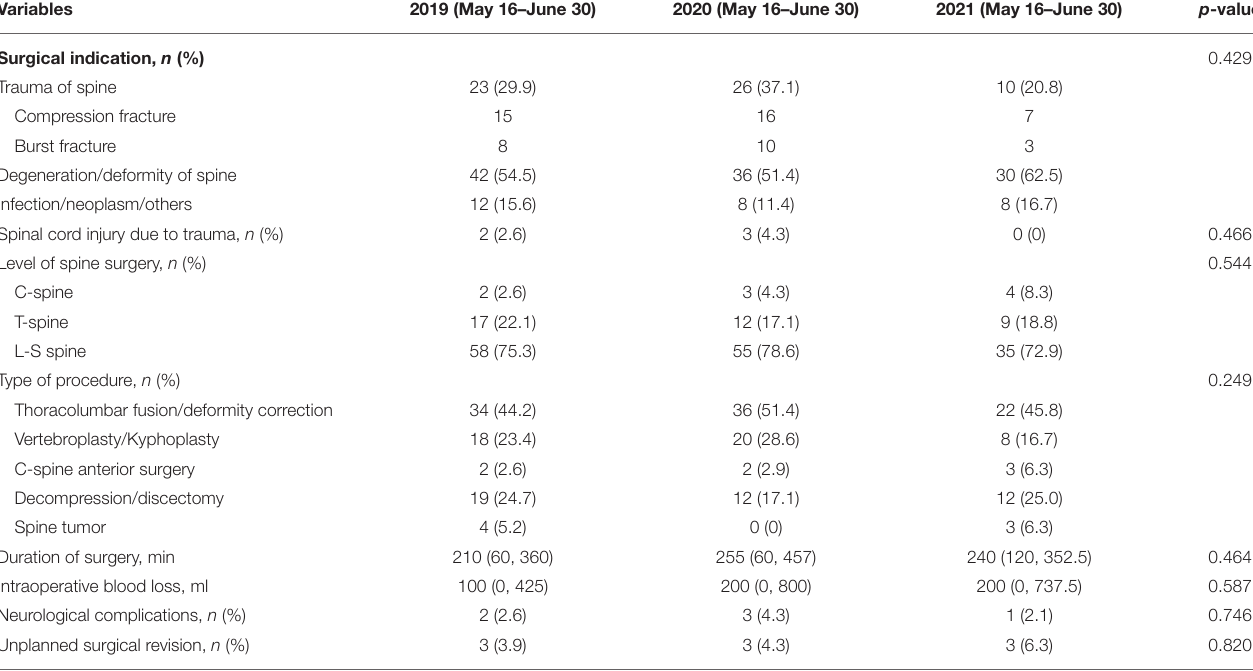
TABLE 2 | Surgical procedures and complications of the study population according to the year of surgery. Variables